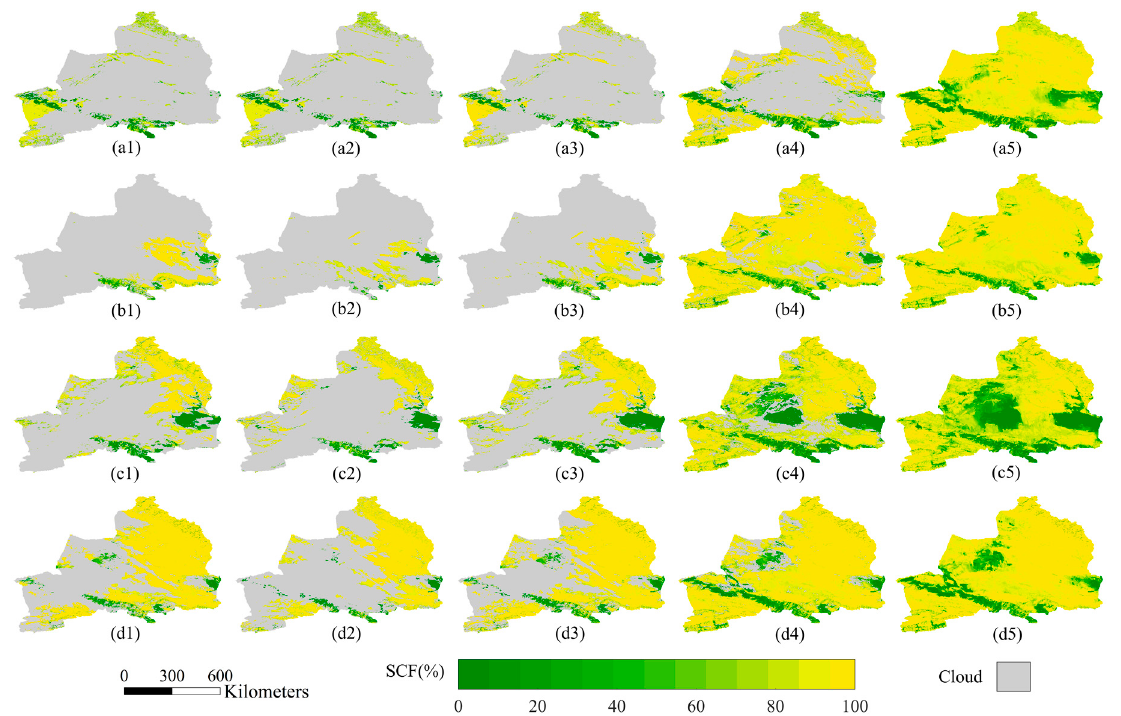
Figure 8. Cloud coverage of the original MODIS SCF images after the execution of each gap-filling step. The results from four days (1 January 2001, 1 January 2005, 1 January 2009, and 1 January 2013) are displayed from top to bottom. The columns, from left to right, represent MOD, MYD, and the three consecutive applications of MOYD, ATF and NSTF,